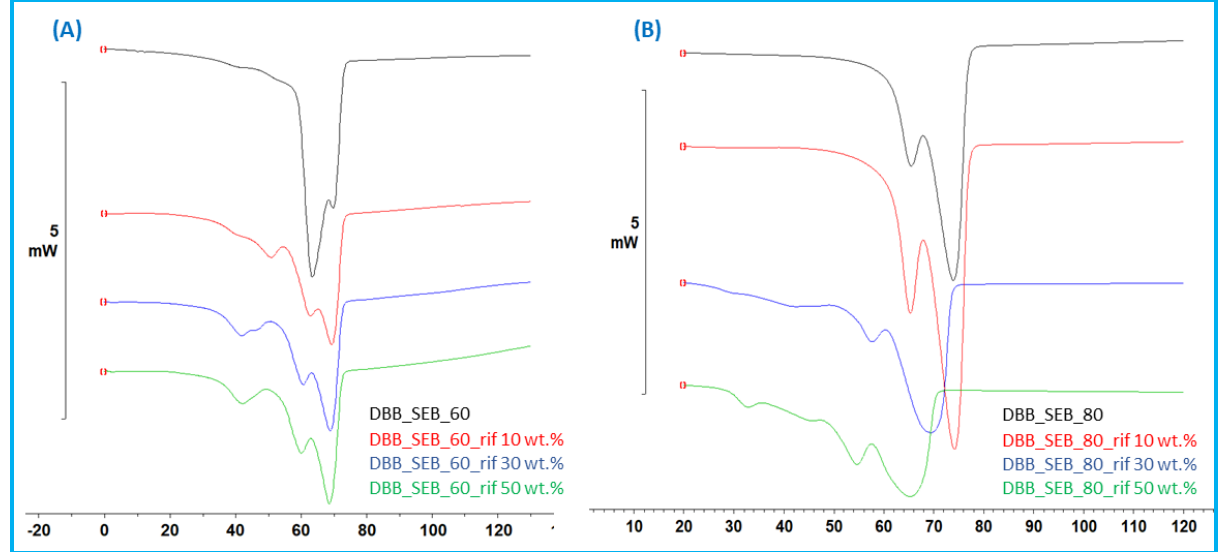
Figure 10. Representative DSC thermograms of RIF – MS obtained from: DBB_SEB_60 ( A ) and DBB_SEB_80 ( B ) with different content of RIF.